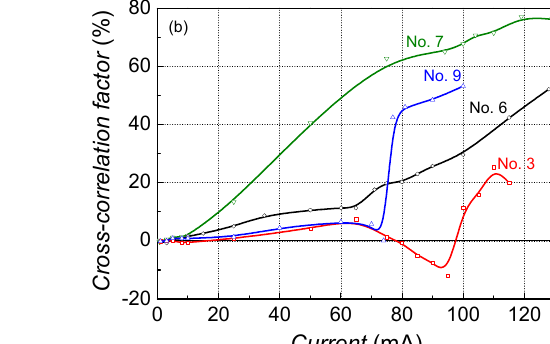
laser diodes with parabolic and rectangular QWs at 108 Hz: in the small current region ( a ); at large currents ( b ).